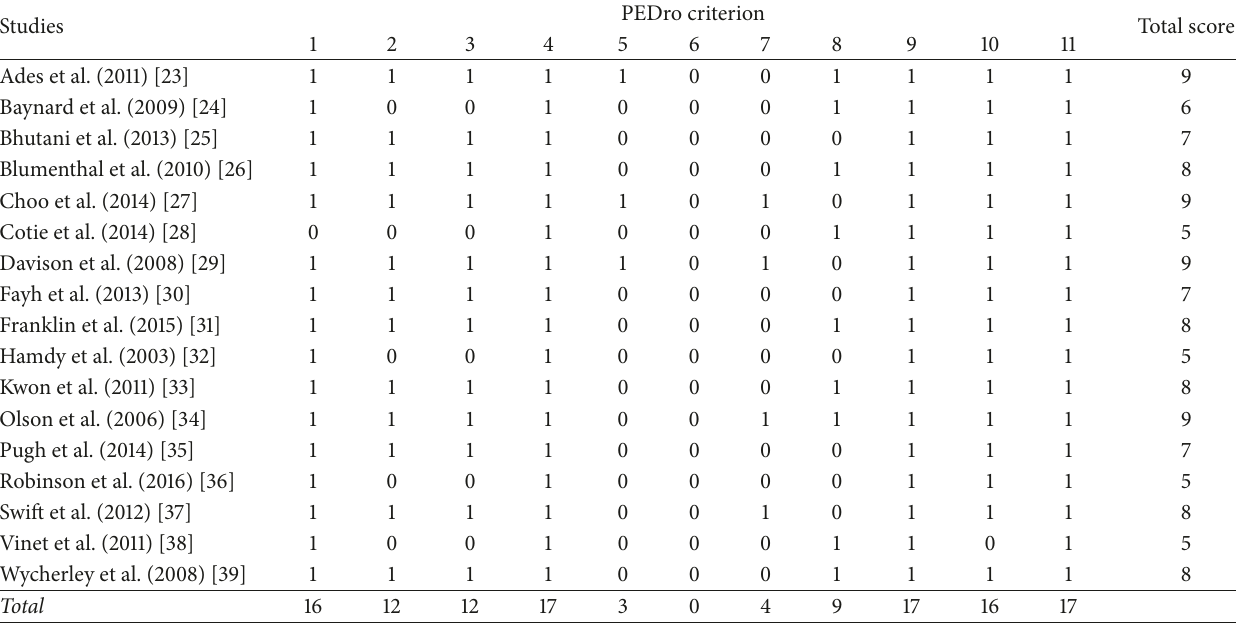
Table 4: Methodological scores by Physiotherapy Evidence Database (PEDro)